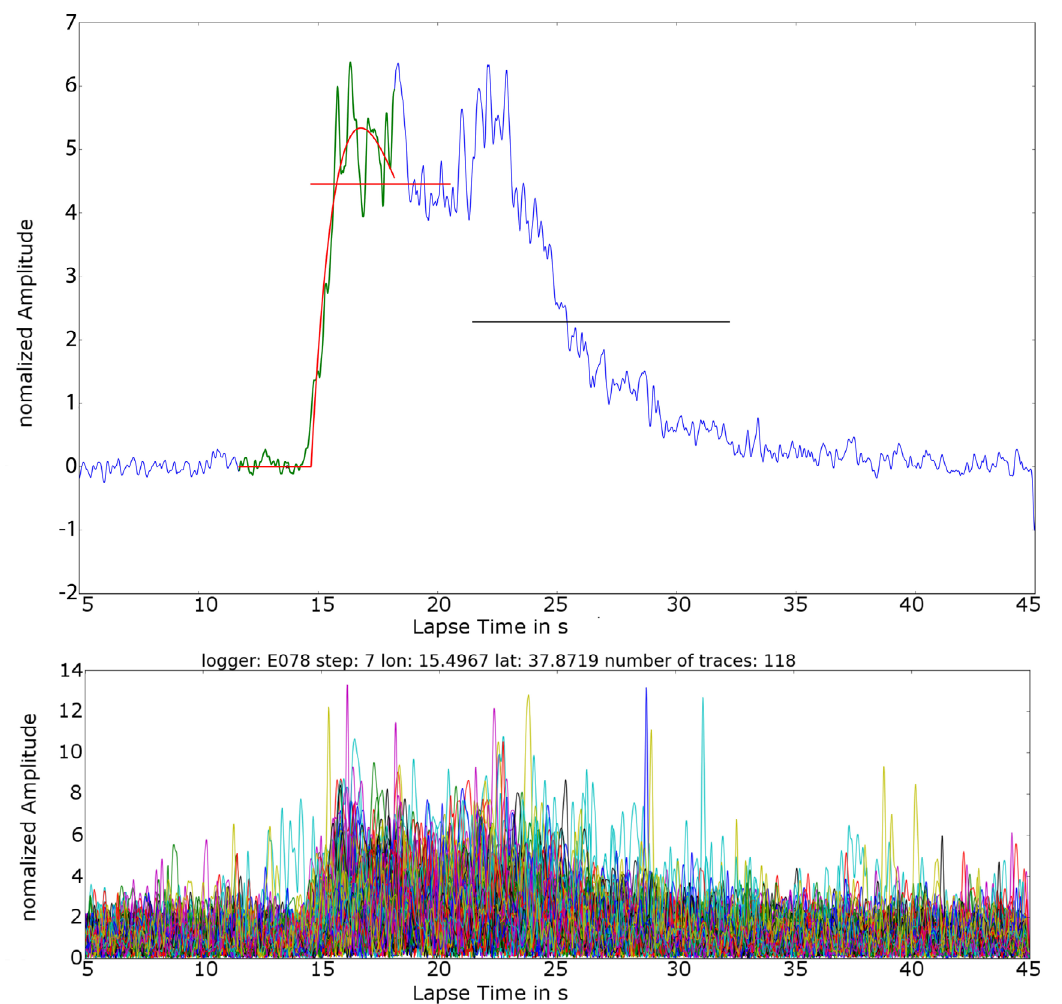
Figure 3. At the top is a data example of a stacked trace (blue) and the fitted function (red) from station E078. The two horizontal lines are the meanvalues of the different time windows. At the bottom you can see the single traces which were used for